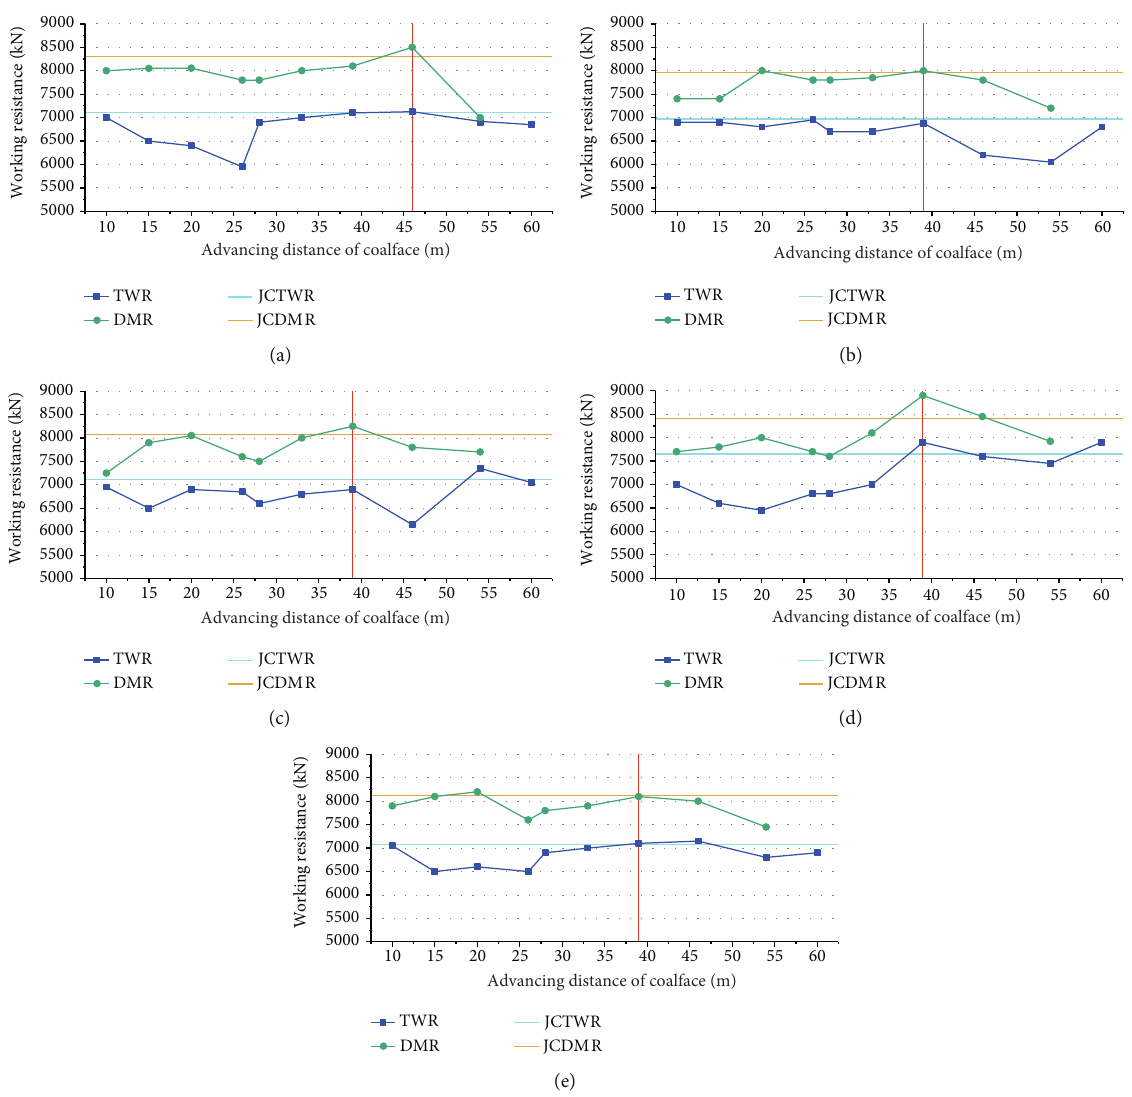
Figure 11: Variation curves of working resistance in some hydraulic supports upon fi rst weighting: (a) #8 hydraulic support, (b) #46 hydraulic support, (c) #92 hydraulic support, (d) #120 hydraulic support and (e) #174 hydraulic